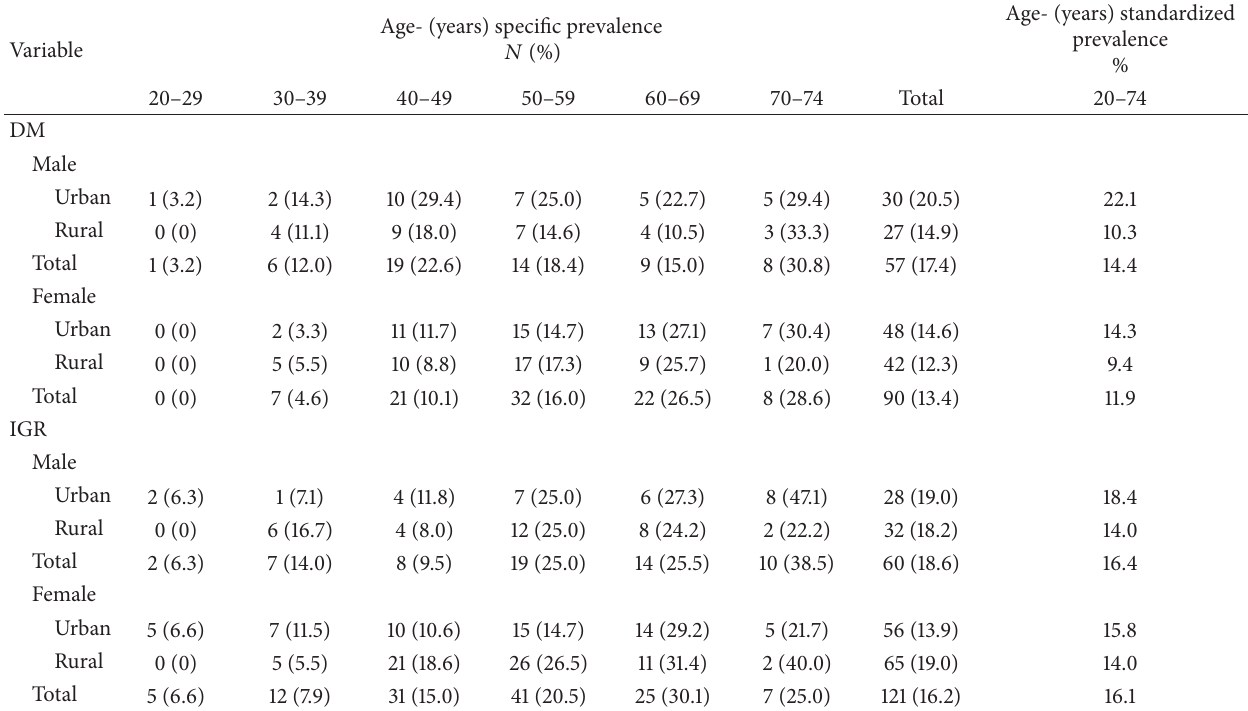
Table 2: Age-specific and age-standardized prevalence of diabetes and impaired glucose regulation in study subjects, by sex and residence.